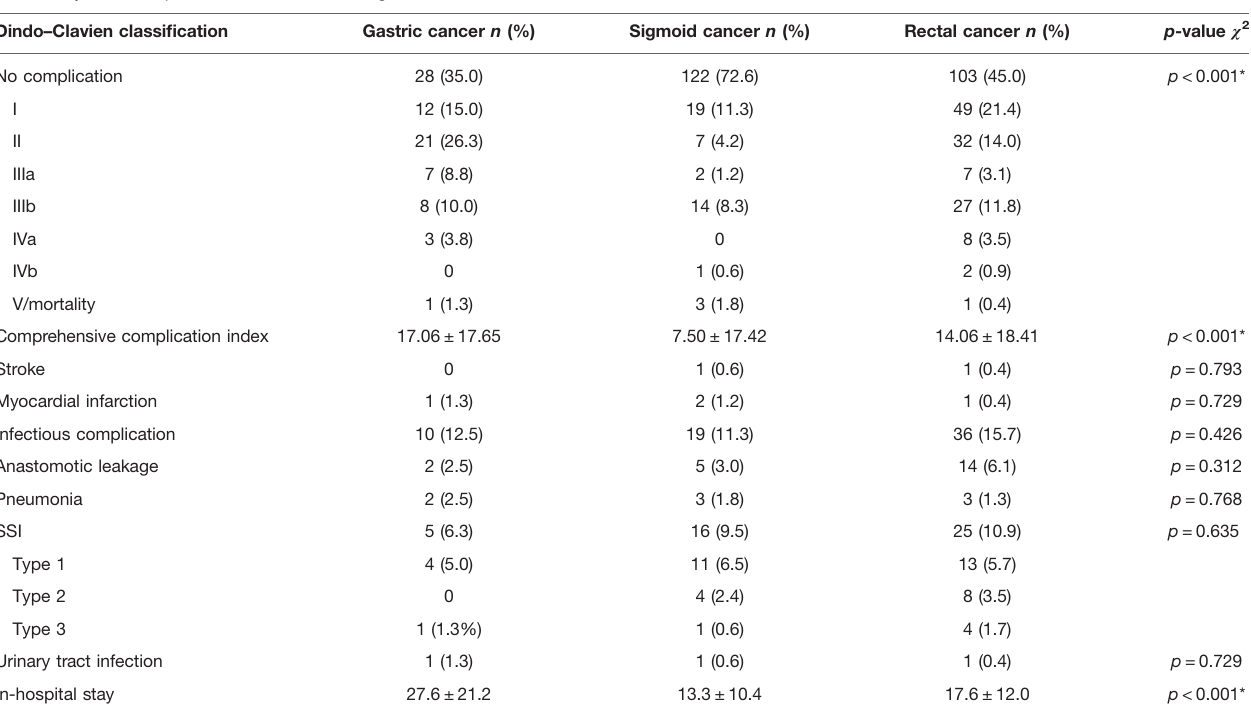
TABLE 2 | Outcome parameters for different